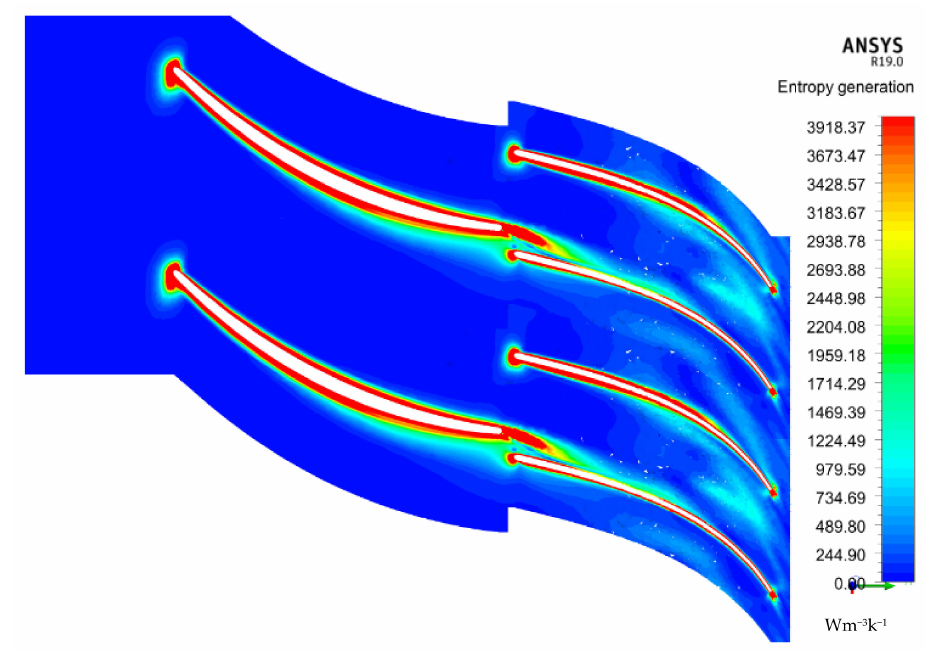
Figure 26. Entropy generation map at 50% span, 75 % clock, 0.5 mm gap configuration m r = 0.33.